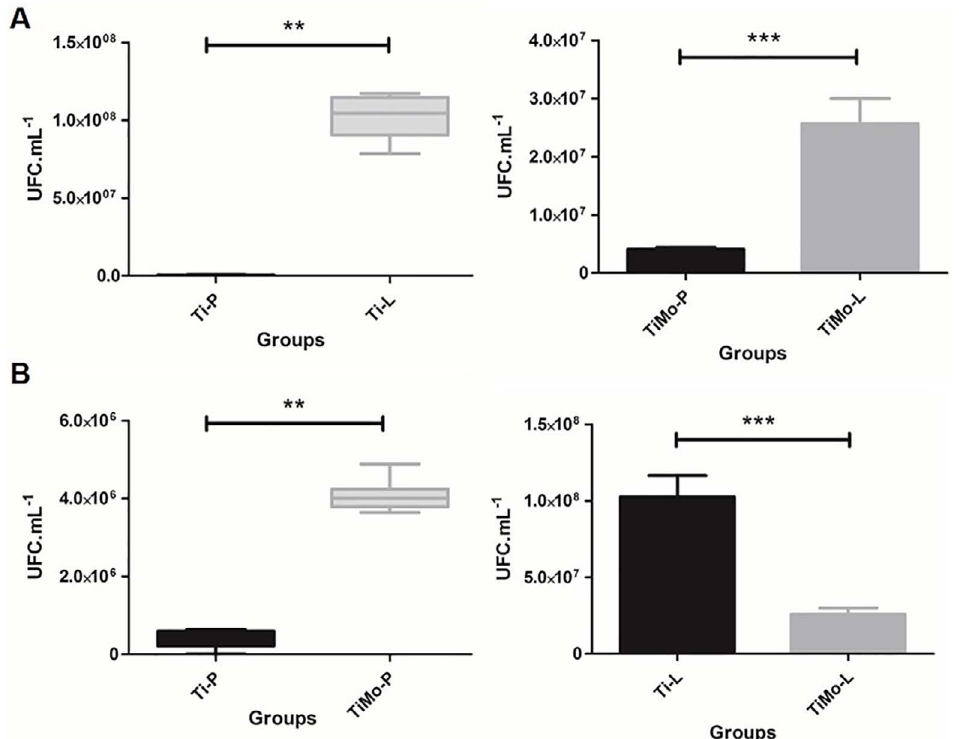
Figure 3. Graphic representation of MRSA cell adhesion to cpTi and Ti-15Mo specimens. (A) MRSA adhesion to Ti and TiMo samples was significantly higher in laser-irradiated compared to polished group (n=9; repeated measures). (B) MRSA adhesion to polished surface was higher in TiMo group compared to Ti; whereas in laser treated samples the bacterial adhesion was statistically higher in Ti group (n=9; repeated measures). **P value ≤ 0.01; Wilcoxon-Signed Rank Test (Box-plot). ***P value ≤ 0.001; Paired t test (Column Graphs).